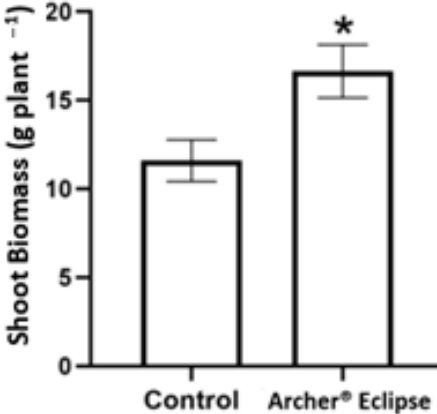
Figure 2. Average shoot biomass of control plants and plants treated with Archer ® Eclipse. Values are means ± standard error (n = 9). Differences between means were compared with Fisher’s least significant difference test (LSD; p = 0.05). The levels of significance were represented by p < 0.05 (*).